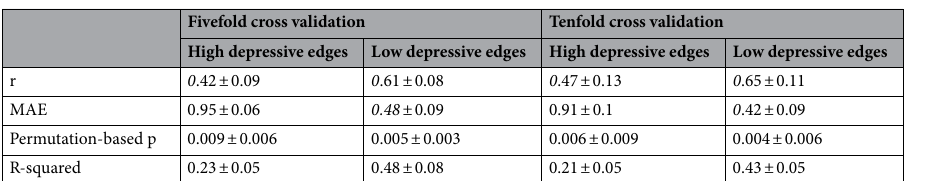
Figure 3. A typical example (chosen from a random iteration) showing the relationship between the observed and the predicted scores using ( A ) low depressive edges, ( B ) high depressive edges, ( C ) combined depressive edges.